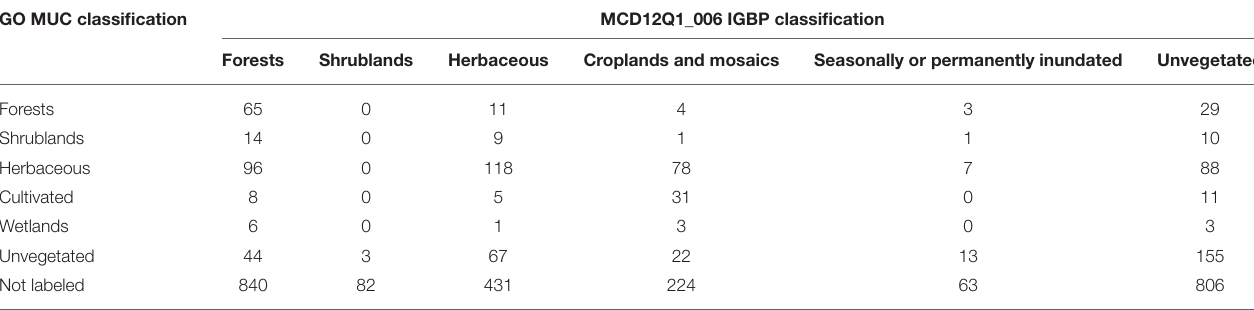
TABLE 5 | Confusion matrix for GLOBE Observer Land Cover classes based on comparison with IGBP